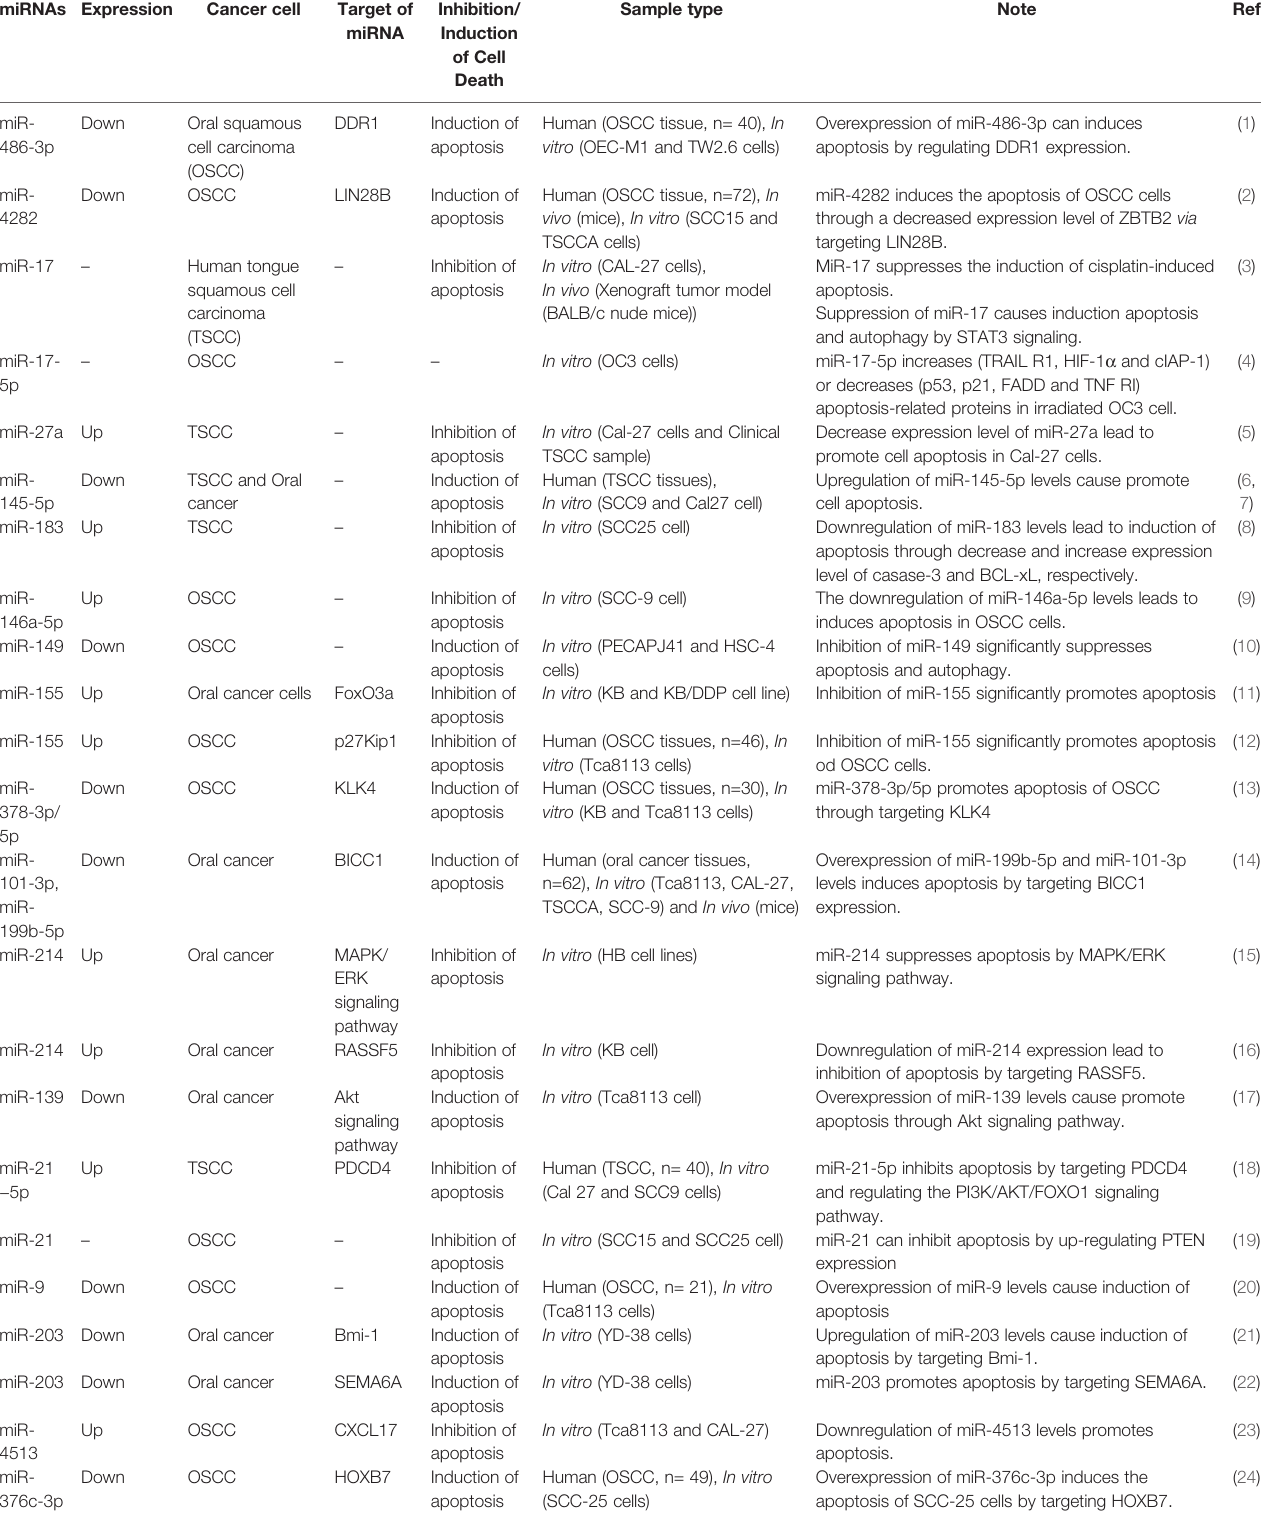
TABLE 3 | microRNA can regulate cell death pathways in oral cancer. miRNAs